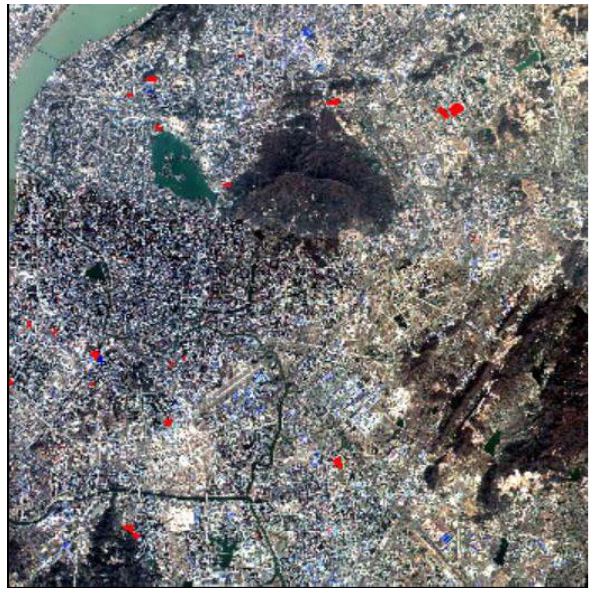
Figure 1. The sample villages dispatch (red area in the image)